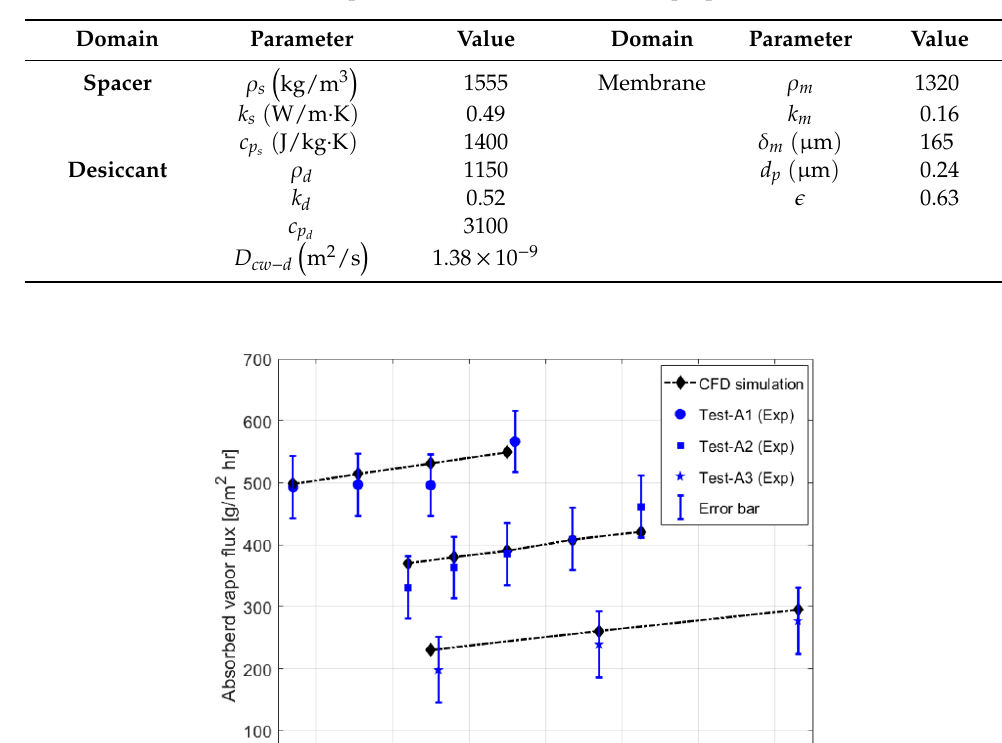
Table 3. Spacer, membrane, and desiccant properties.